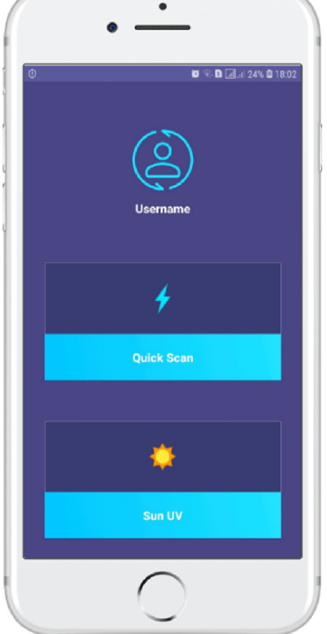
Figure 4. Application screenshot: main menu.